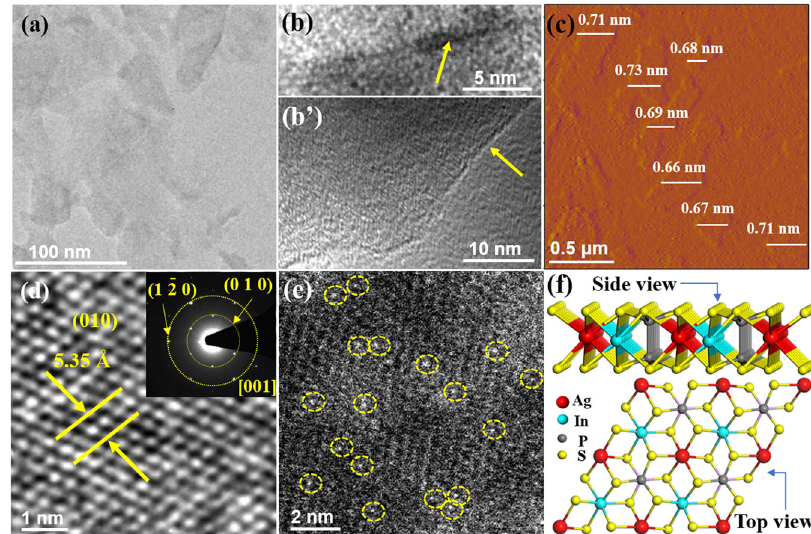
Fig. 1 Morphological structure characterization of the fabricated SAL and V S -SAL 10 . TEM images of a SAL, b vertically standing, and b ’ laying single piece SAL, c AFM image of SAL showing an average thickness of ~0.69 nm. d HRTEM image and the EDS. e HAADF-STEM image of V S -SAL 10 , in which the atomically dispersed V s are highlighted with the yellow circles. f The crystalline models of SAL from top and side views.